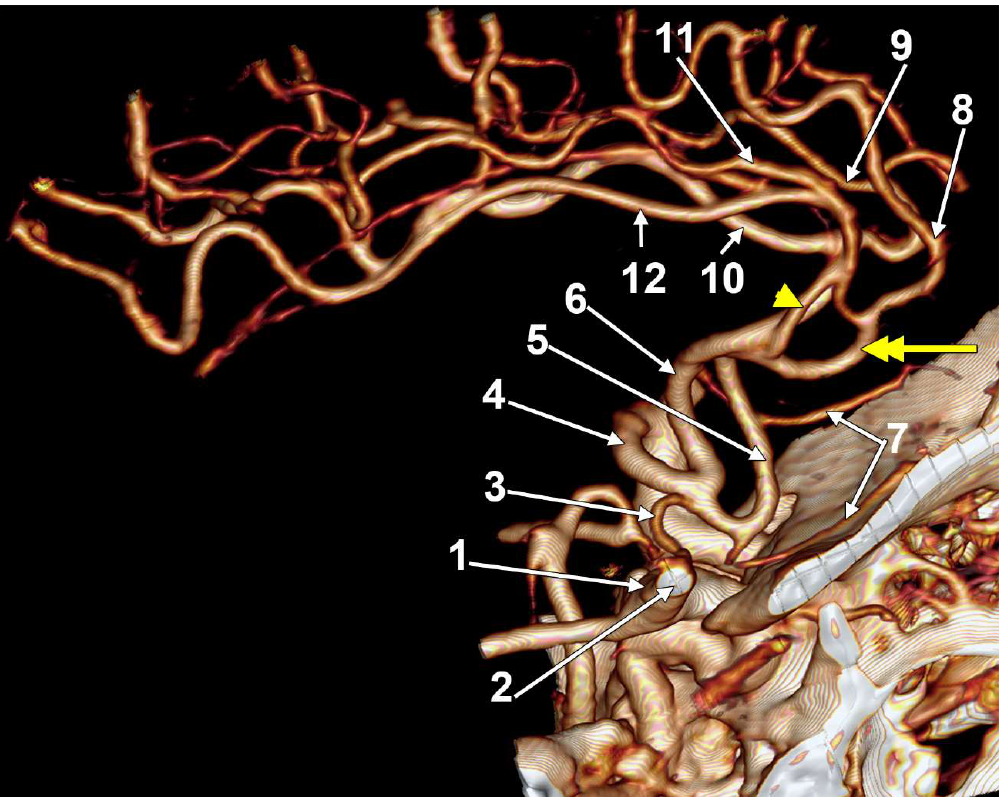
Figure 5. Three-dimensional volume rendering, right lateral view of the anterior cerebral arteries (ACAs): 1. right internal carotid artery; 2. right middle cerebral artery; 3. hypoplastic A1 segment of the right ACA; 4. A1 segment of the bihemispheric left ACA; 5. right A2 segment; 6. left A2 segment; 7. bilateral orbitofrontal branches; 8. right callosomarginal artery; 9. left callosomarginal artery; 10. left pericallosal artery; 11. right cingular branch; 12. right pericallosal artery. A huge fenestration of the right A2 segment consists of a postero-lateral arm (arrowhead) and an antero-medial one (double-headed arrow). The A2 segments are twisted in the interhemispheric fissure.